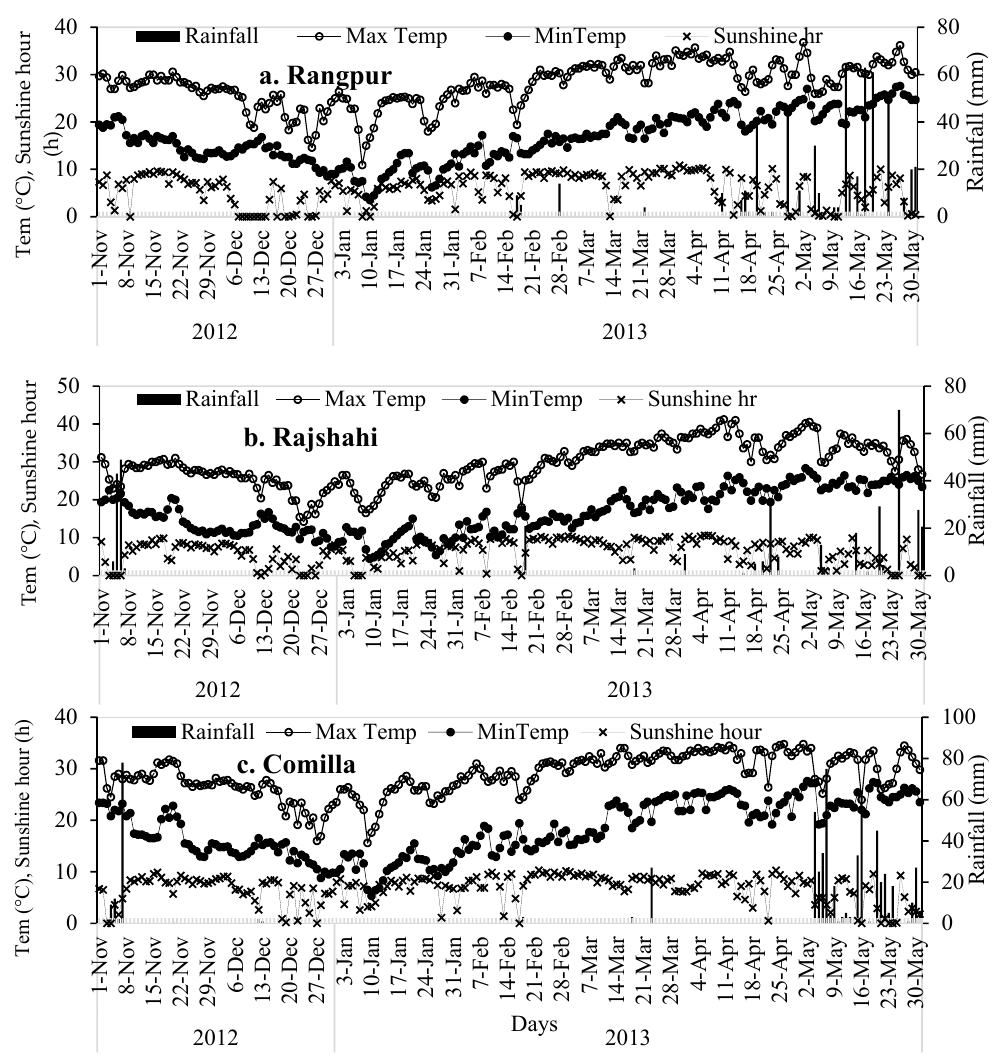
Figure 3. Daily maximum and minimum temperatures (°C), sunshine hour (h) and total rainfall (mm) during the rabi maize season from November 2012 to May 2013 in experimental sites (a. Rangpur, b. Rajshahi, c. Comilla) in Bangladesh.